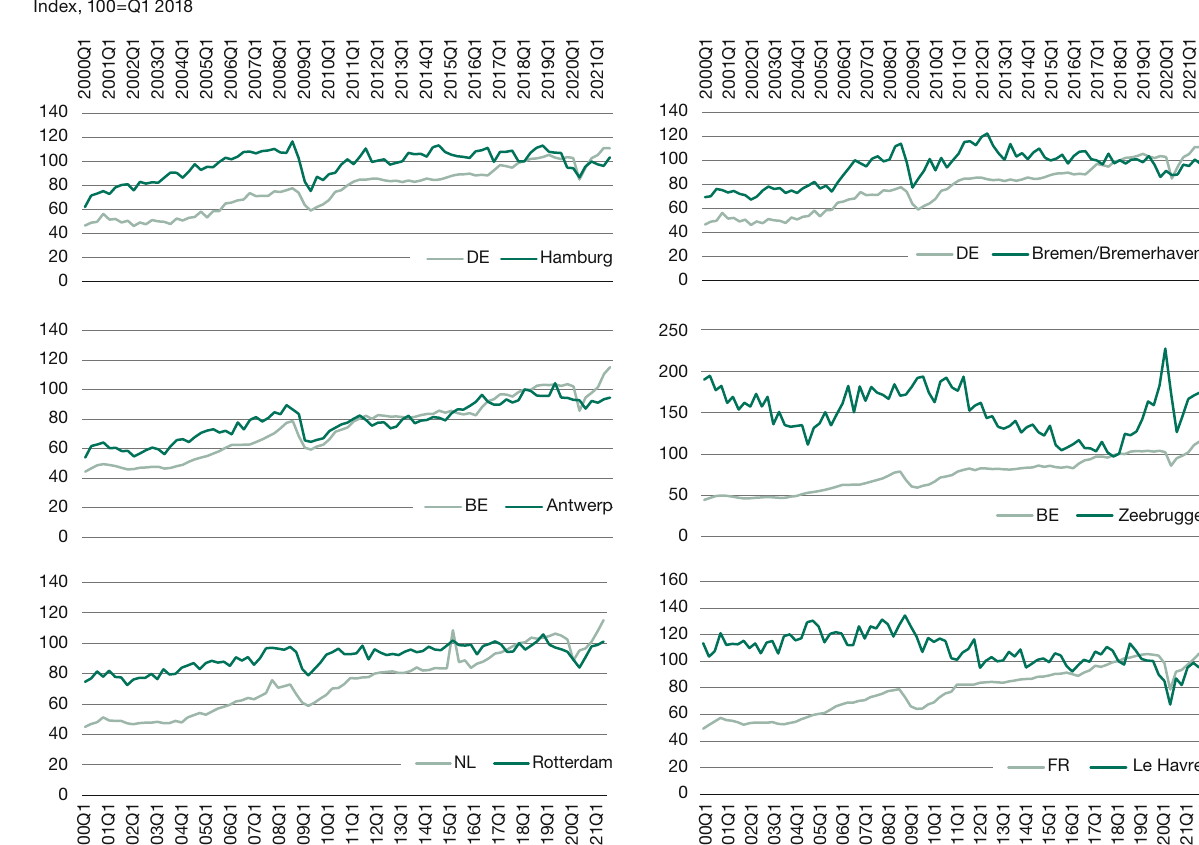
Figure 2 The infl ow of North Range ports and North Range countries,